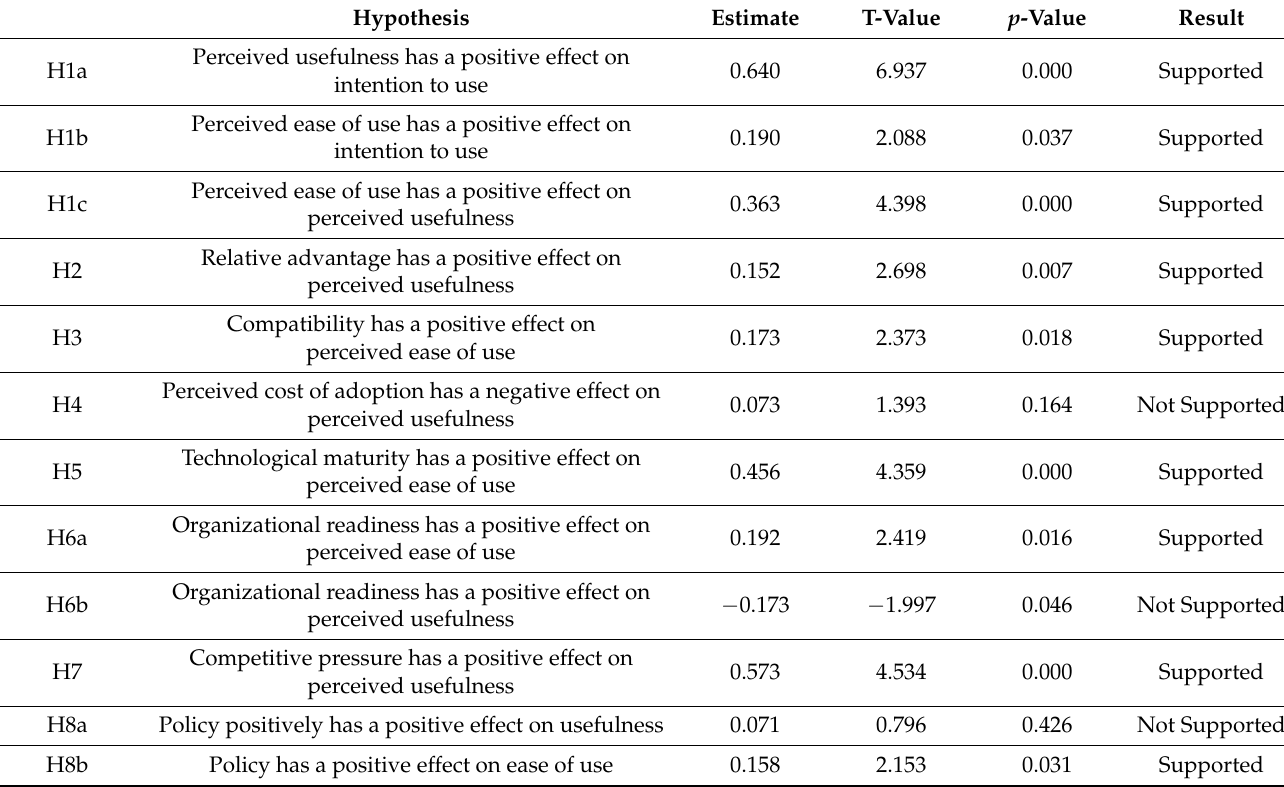
Table 6. Hypothesis testing.